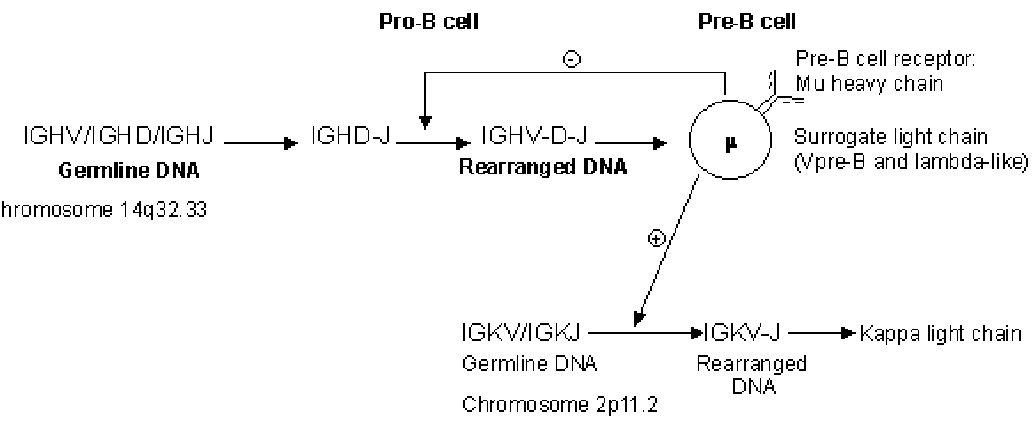
Figure 12. Regulation of the immunoglobulin gene rearrangements in the pre-B cell [2]. The expression of the pre-B cell receptor gives the signal which inhibits further IGHV-D-J rearrangements on chromosome 14, and the signal which starts the IGKV-J rearrangements on chromosome 2 [2]. (With permission from M-P. Lefranc and G. Lefranc, LIGM, Founders and Authors of IMGT ® , the international ImMunoGeneTics information system ® , http://www.imgt.org).